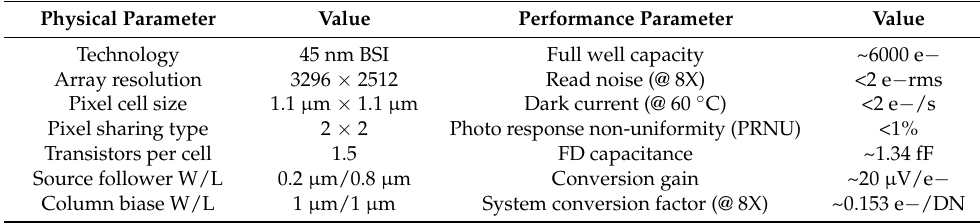
Figure 1. A simplified schematic of the signal chain. The 3296 × 2512 pixel array consists of 1648 × 1256 groups of 2 × 2, 4-shared pixels. Four off-chip 14 bits ADCs digitize the buffered analog voltages and the off-chip FPGA combines and outputs the digital data at 10 MHz clock. The even column pixels and the odd column pixels are read out in the first and the second half line time. Table 1. The 8.3 MP CMOS Image Sensor (CIS) physical and performance parameters.